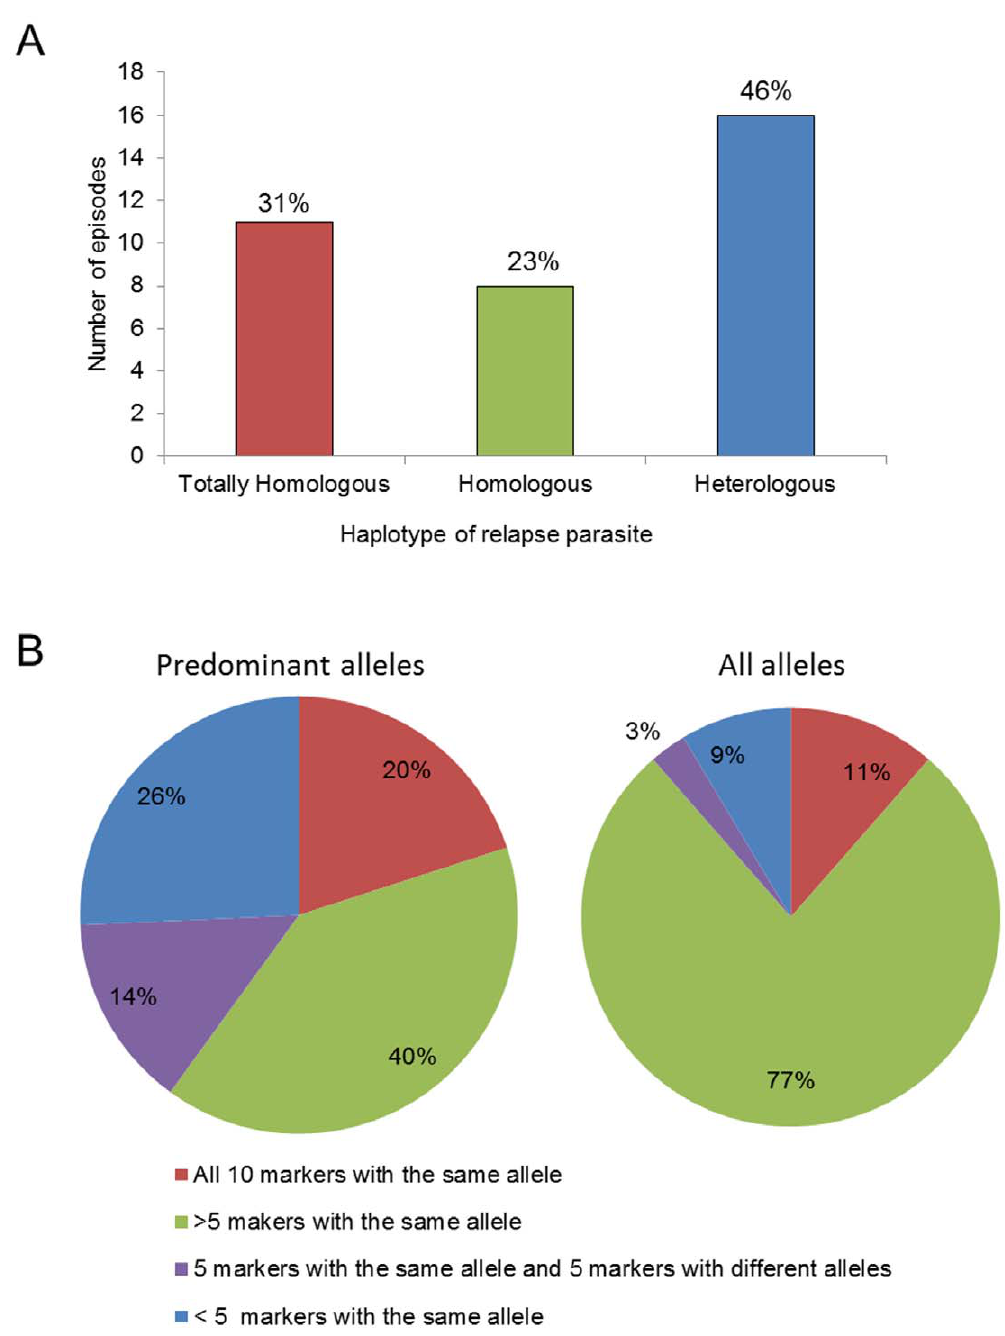
Figure 1. Genotyping of P.vivax primary/relapse paired parasites from 30 patients using 10 molecular markers. (A) Haplotype derived from predominant allele of each marker. Totally homologous – parasites showing all markers with the same allele; Homologous or Related – parasites with 8 to 9 markers with the same allele; Heterologous – parasites showing less than 8 markers with the same allele (according to Orjuela-Sa´nchez et al. [21]). In patients with more than one relapse episodes, relapse parasites were compared with the previous acute malaria episode. (B) Percent of acute malaria episodes showing different amounts of markers with the same alleles, taking into account only the predominant allele from each marker (left) or all alleles, predominant and rare from each marker (right). Genetic diversity of primary and relapse parasites was compared using analysis of molecular variance - AMOVA [38]. We calculated the gene diversity (expected heterozygosity, H E ), defined as the probability that a pair of alleles randomly obtained from the population differ, using Arlequin 3.0 software [37].